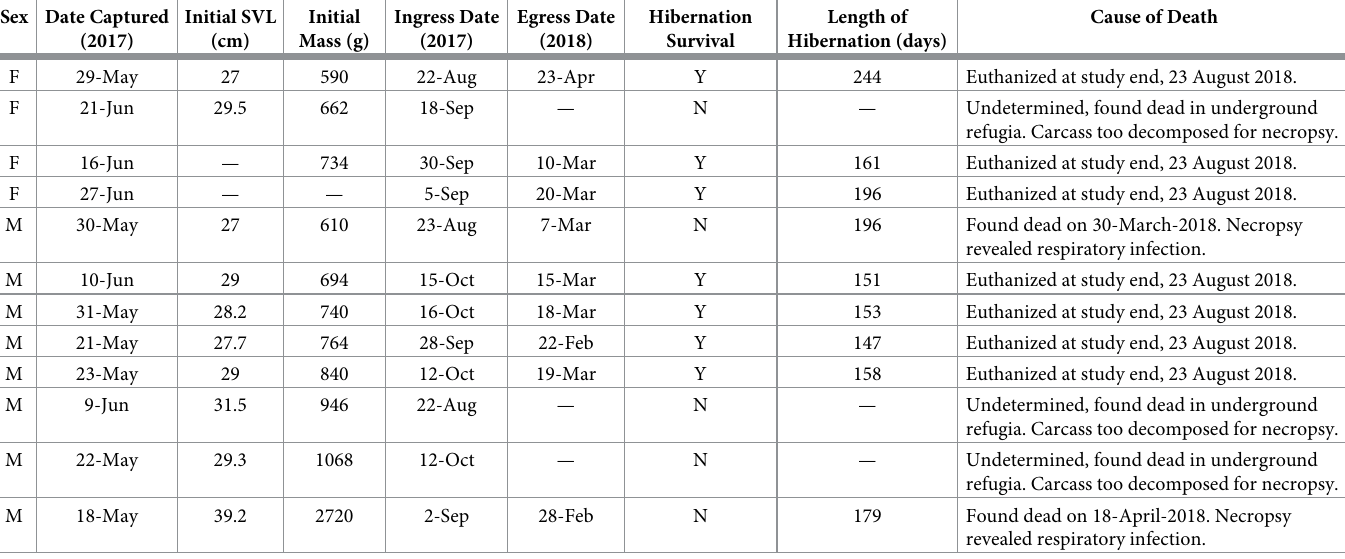
Table 1. Tegu ( Salvator merianae ) morphological data, behavior, and fate.